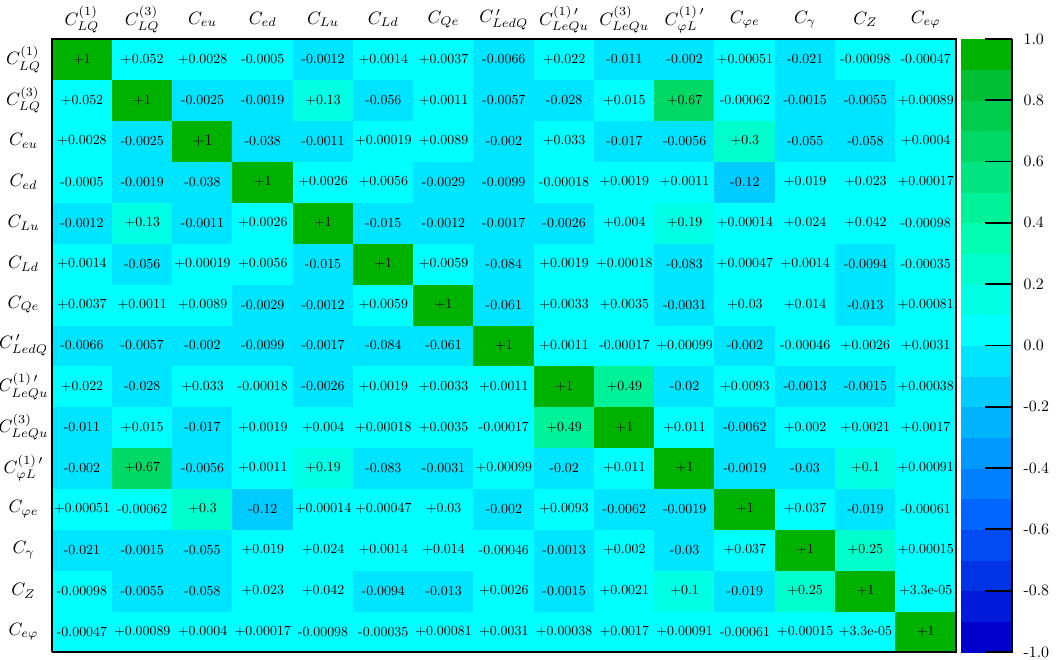
Figure 12 . Correlations among all the Wilson coefficients from the numerical analysis considering ‘ - τ limits and including